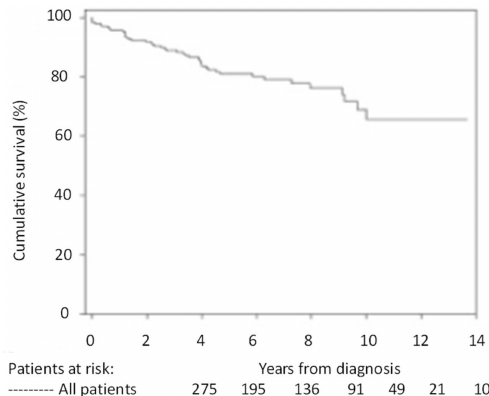
Figure 1. Kaplan–Meier curves showing the survival pediatric pulmonary arterial hypertension (PAH) patients compiled at 3 pulmonary hypertension (PH) centers (Denver, New York, Netherlands): 1-, 3-, 5- and 7-year transplantation-free survival rates were 96%, 89%, 81% and 79%, respectively [4].